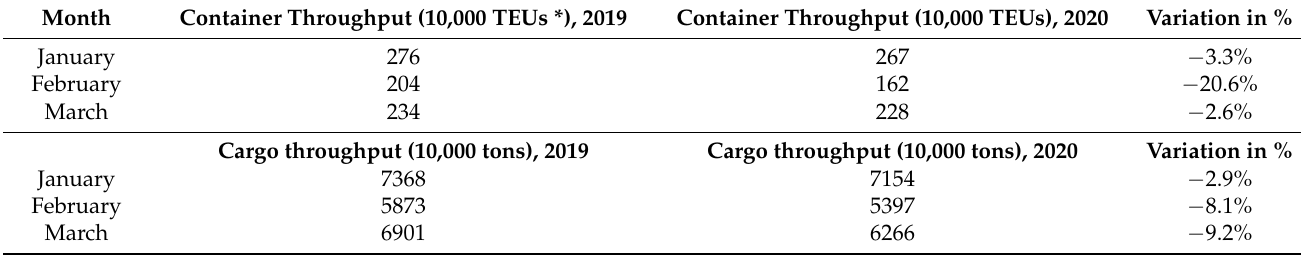
Table 4. Statistics of the container throughput and cargo throughput of Ningbo Zhoushan Port Co., Ltd. (Ningbo, China) from January to March 2020 and compared with those from January to March